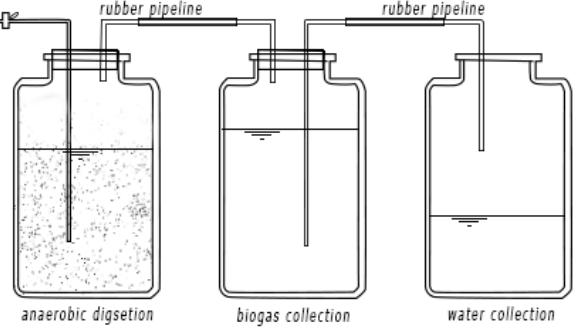
Figure 1. The batch anaerobic digestion (AD) of experimental set up.